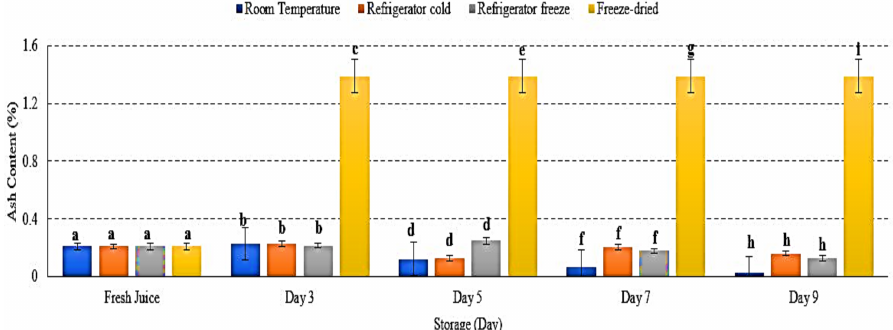
Figure 3. The ash content (%) of watermelon juices during storage at room temperature, refrigerator cold, refrigerator freeze and freeze-dried. Different letters indicate significant differences between samples p <